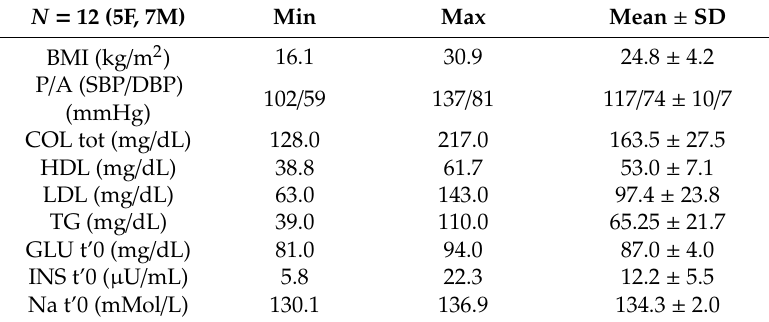
Table 1. General characteristics of the study participants.